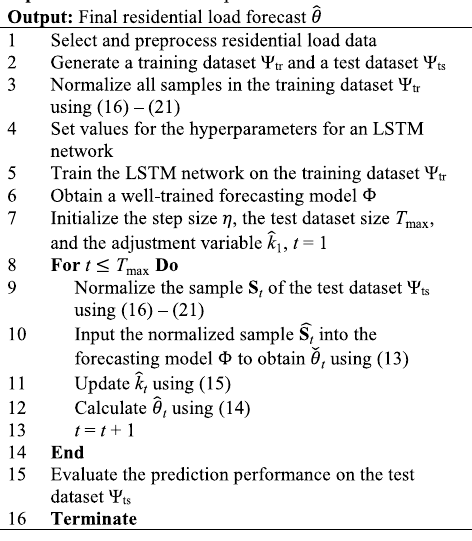
TABLE2Experimentparametersofadaptiveindividualresidentialload forecasting based on deep learning and dynamic mirror